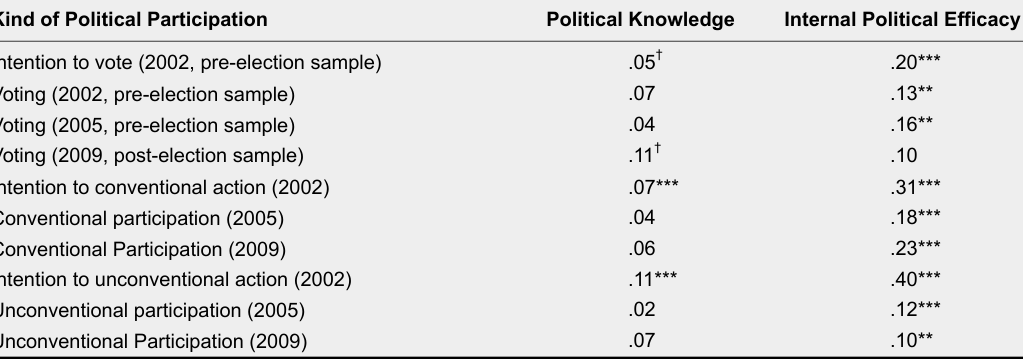
Bivariate Correlations Between Political Participation and Political Knowledge and Efficacy Intention to vote (2002, pre-election